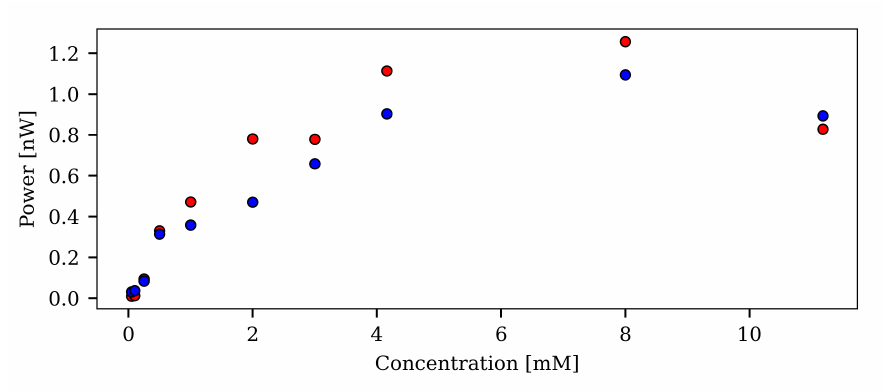
Figure 11. The effect on higher concentrations. Fiber sensors have been manufactured with increasing concentrations of PtOEP using the 1:3 acetone/TCE solvent mixture, ensuring a good dispersion of the compounds. With increasing concentration the effect is, at first, the increase of photoluminescence signal. However, when the concentration rises above 8 mM, the signal drops. It therefore seems that the concentration should stay below this threshold, to ensure that no self-quenching